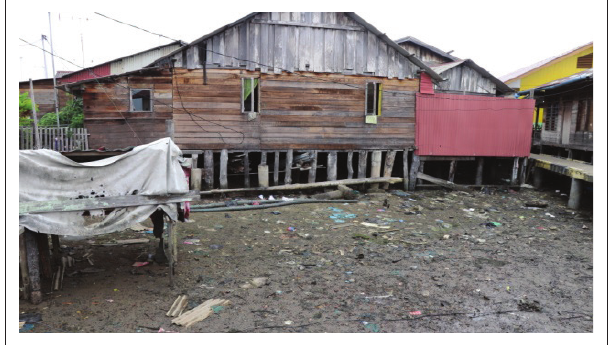
FIGURE 5: Environmental conditions in Pusong